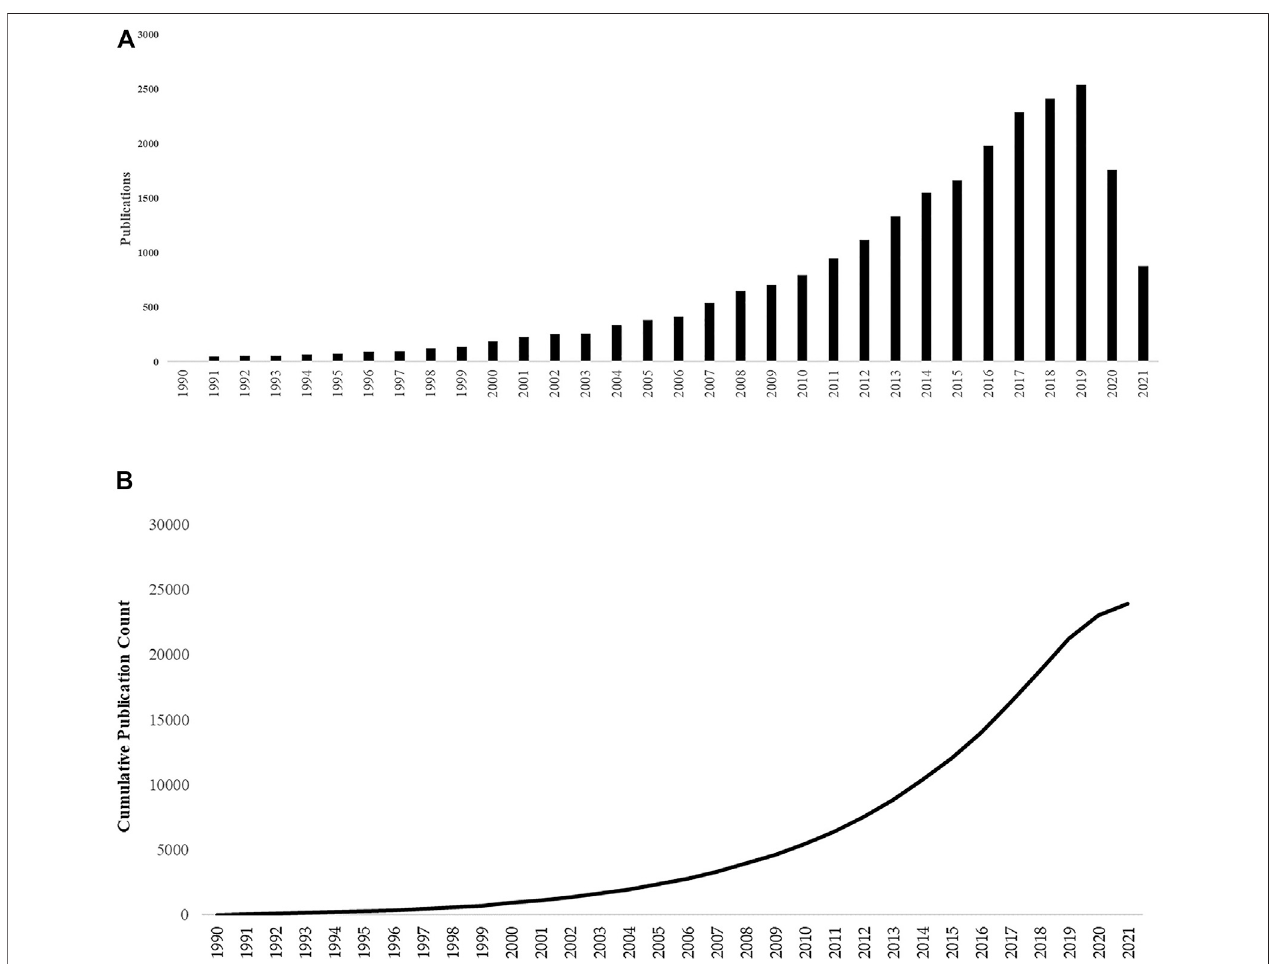
FIGURE 2 | (A) The graph depicts the total number of publications over the years. (B) : The graph depicts the accumulation of publications throughout the 3 decades.